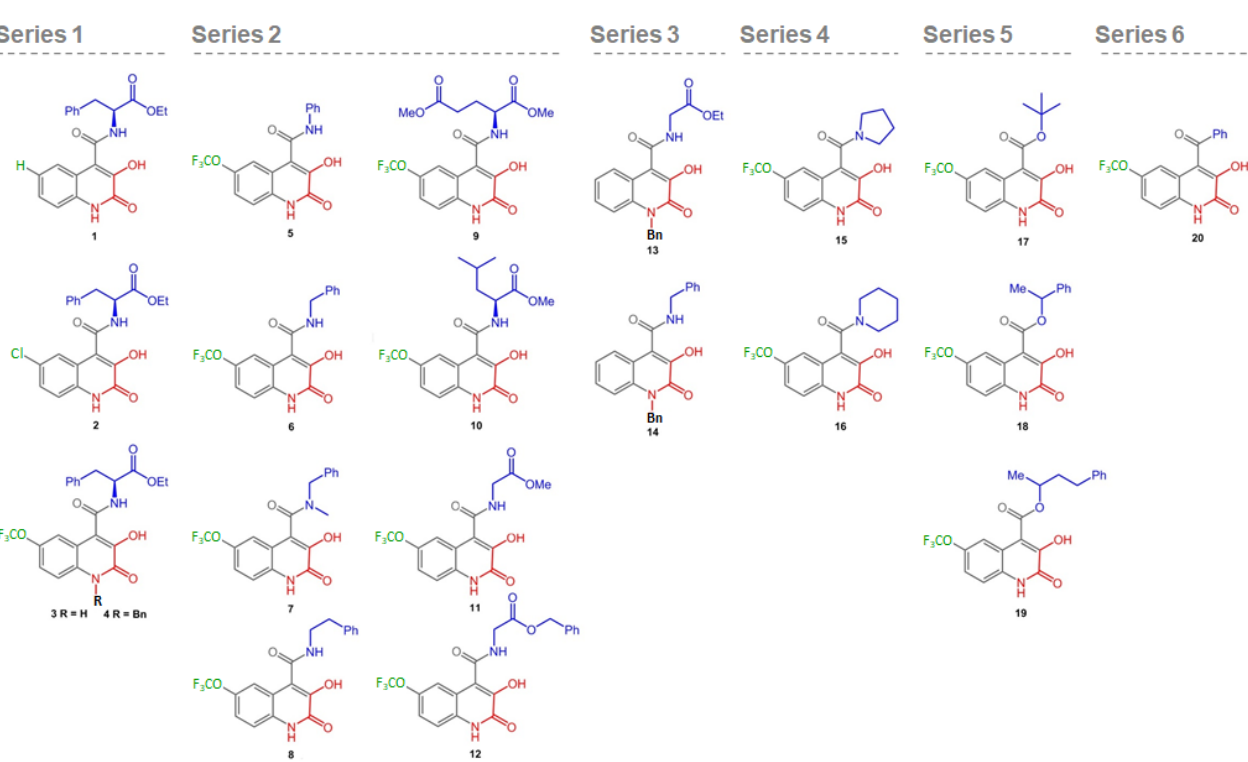
Figure 2. Chemical structures of 3-hydroxyquinolin-2(1H)-one (3HQ) derivatives screened. The compounds display a common 3HQ core, with variations at positions 1 (black), 4 (blue) and 6 (green); substituents include aliphatic motifs (benzyl, ethyl and methyl), aryl (phenyl) and electron withdrawing groups (chloride and trifluoromethoxy); the putative iron chelating moiety is represented in red.